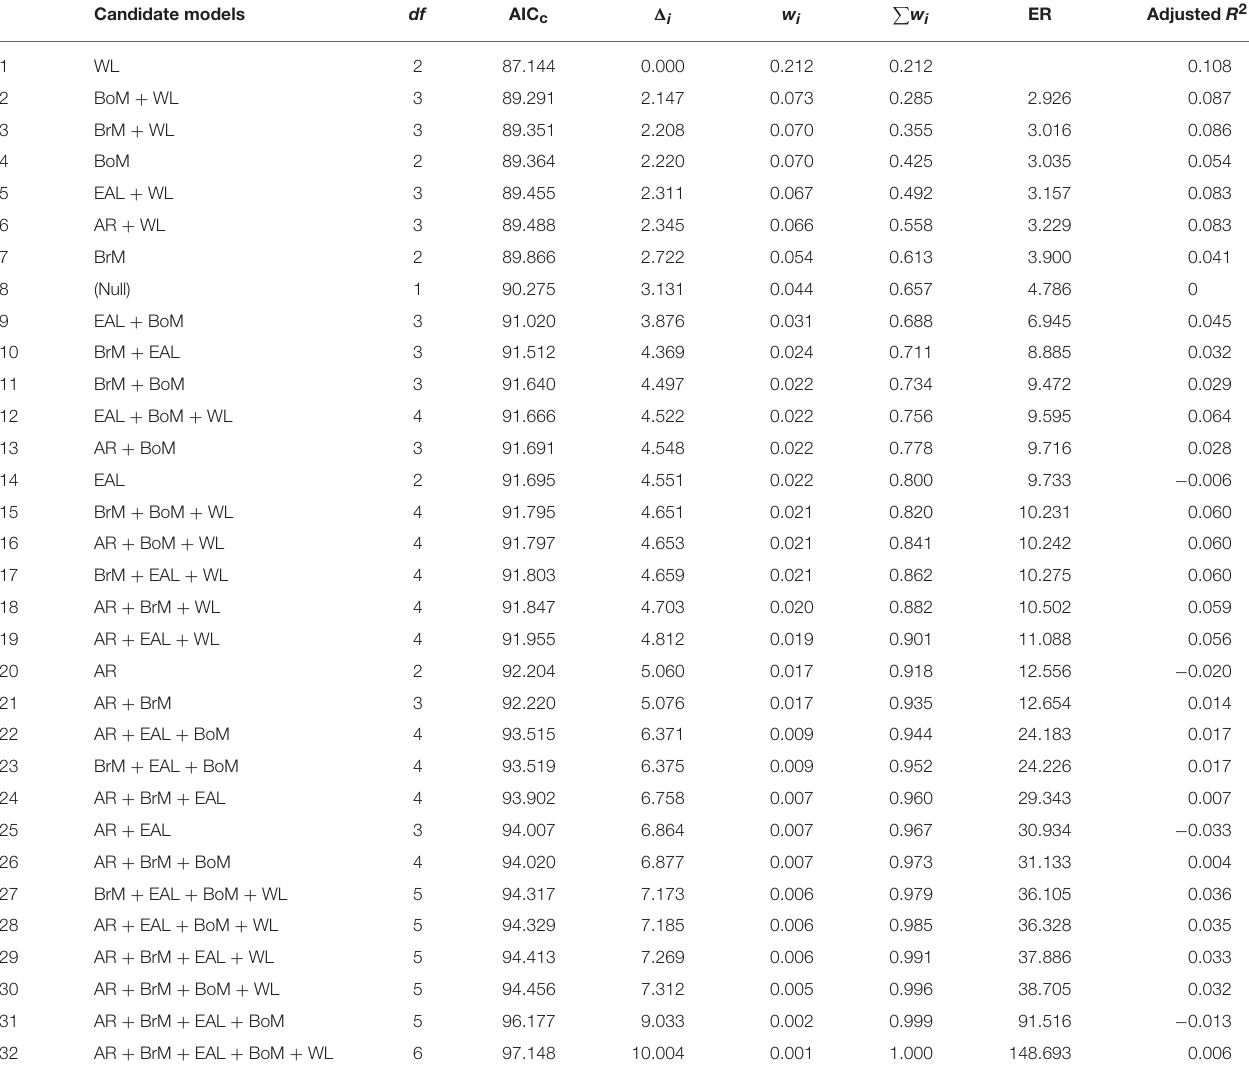
TABLE 1 | Summary of 32 candidate models assessing the effects of body mass (BoM), eye axial length (EAL), brain mass (BrM), wing loading (WL), and wing aspect ratio (AR) on the frequency of bird strikes following different criteria: Akaike’s Information Criterion (corrected for sample size, AIC c ), AIC c difference ( 1 i), Akaike weight (w i ), and Evidence Ratio